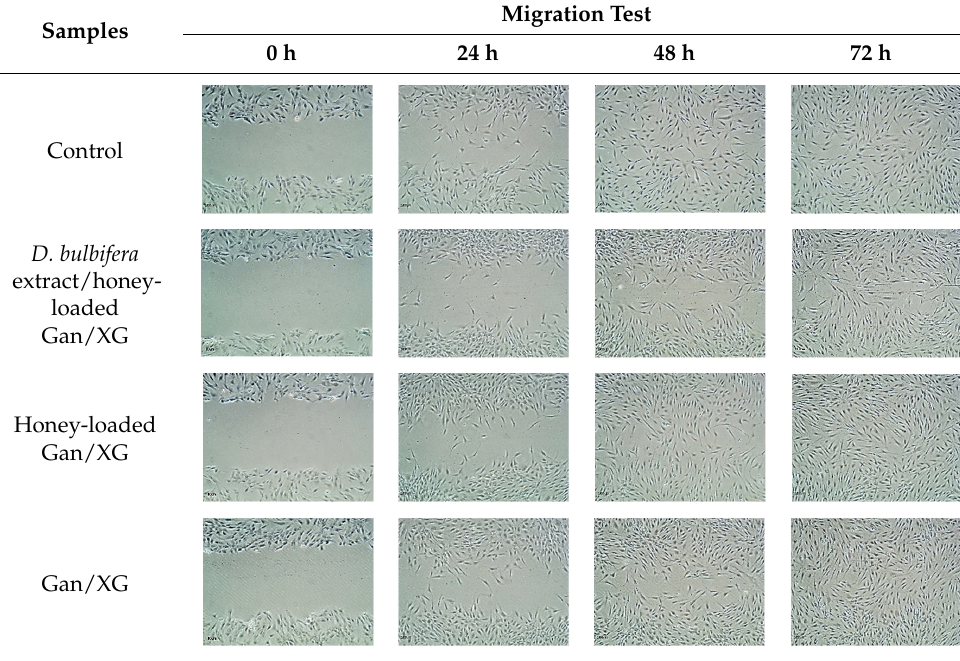
Table 5. Infiltration test of the hydrogel patches.